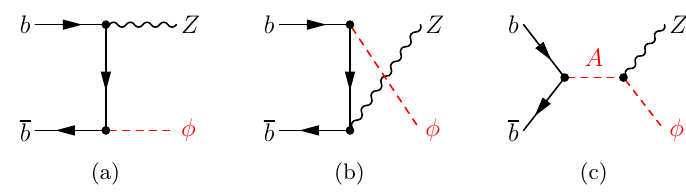
Figure 2 . Feynman diagrams for bottom-quark initiated Higgs Strahlung, (cid:27)